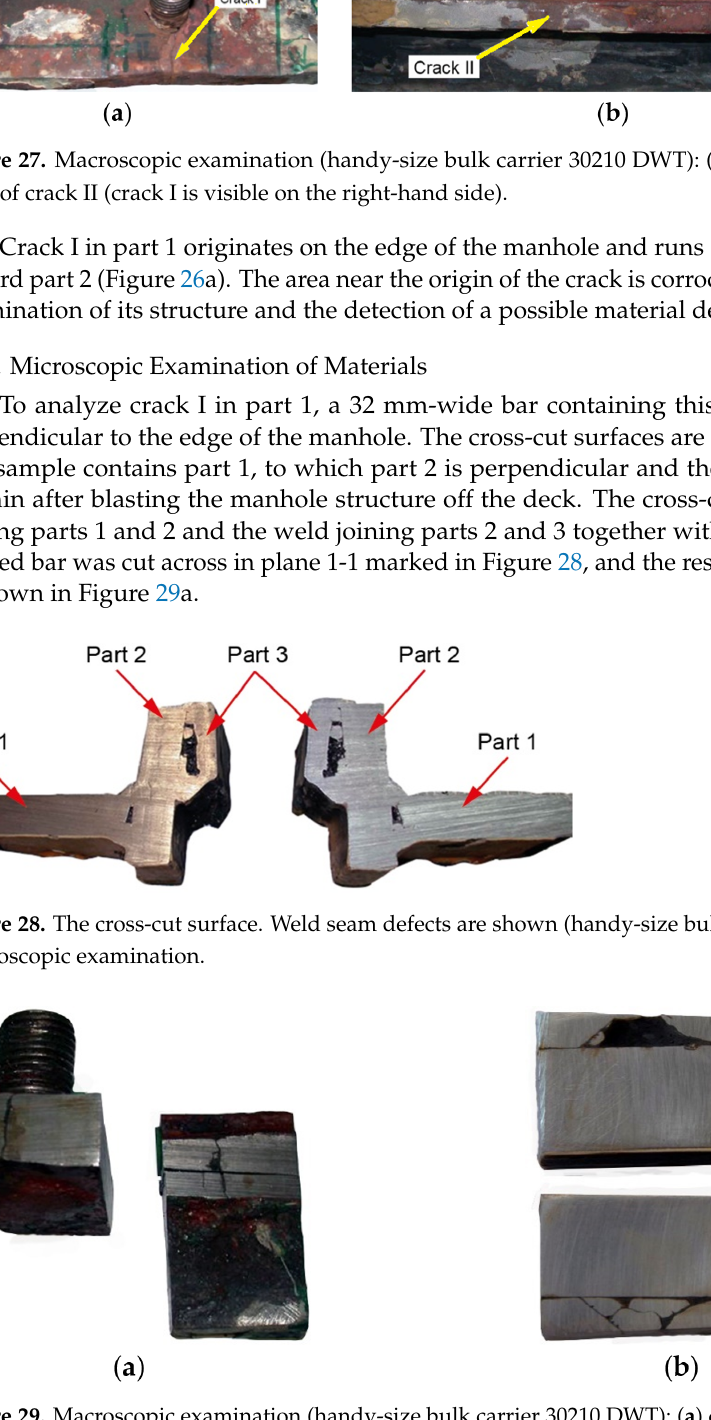
Figure 29. Macroscopic examination (handy-size bulk carrier 30210 DWT): ( a ) crack I and the cutting plane 2-2 and ( b ) the branching end of crack